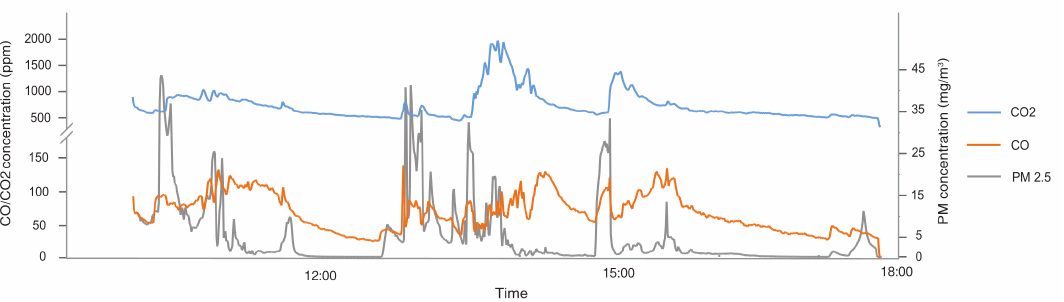
Figure 5. Typical real-time emission pattern for CO 2 , CO , and PM 2.5 in